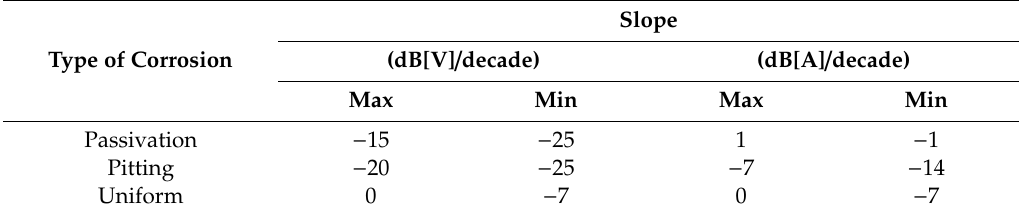
Table 4. Slopes of power spectral density (PSD) of electrochemical noise for di ff erent types of corrosion.